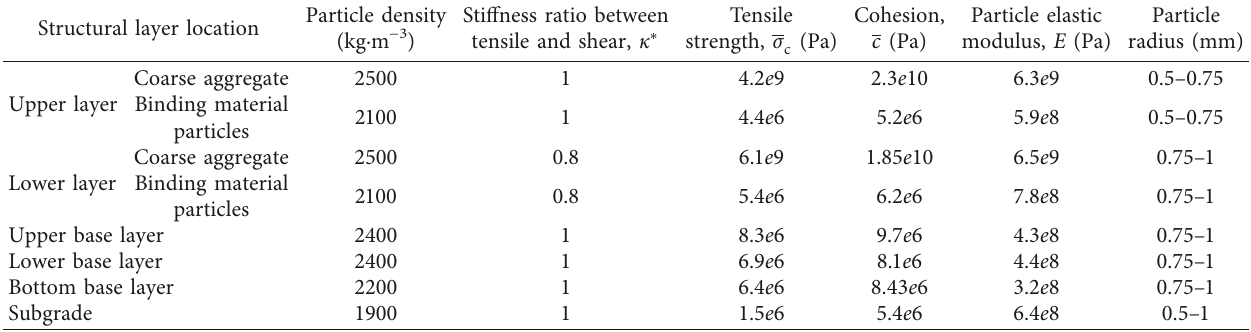
Table 3: Microscopic parameters of linear parallel bond model in the asphalt mixture.